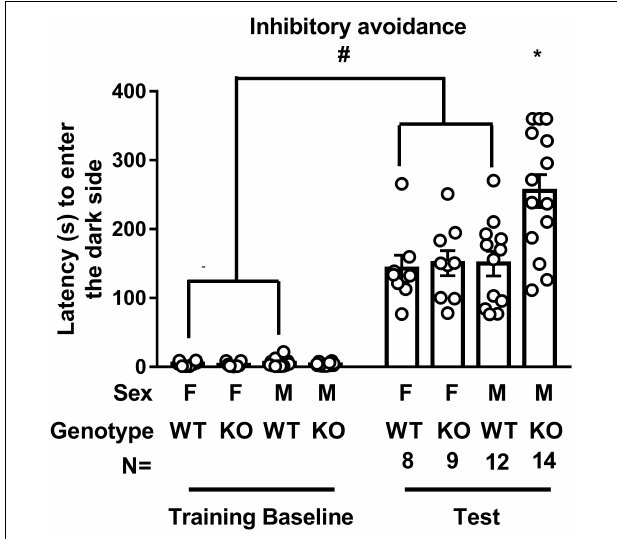
FIGURE 2 | Inhibitory avoidance training and test latency to enter the dark compartment. WT mice’ latency to enter the dark compartment in the test was significantly longer than it was in the training baseline. SEPT14 KO did not seem to affect the latency to enter the dark compartment in female mice, while this SEPT14 KO enhanced the latency to enter the dark compartment in male mice. F, M, WT, and KO are short forms of female, male, wild type, and Septin-14 knockout, respectively. # Significantly higher than training baseline ( p < 0.05). *Significantly higher than the remaining three groups in the test ( p < 0.05). The bar and error bar represent the group mean and standard error of mean (SEM),